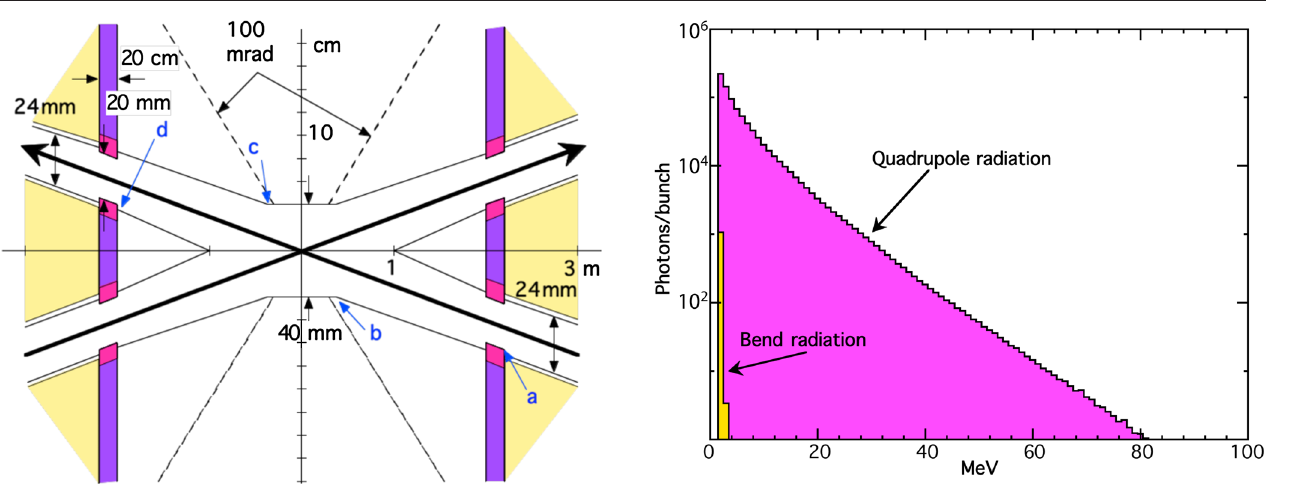
FIG. 2. Closer view of the FCC-ee IR layout (cid:3) 3 m from IP. In front of QC1 (in violet) is the possible location to the luminometer.